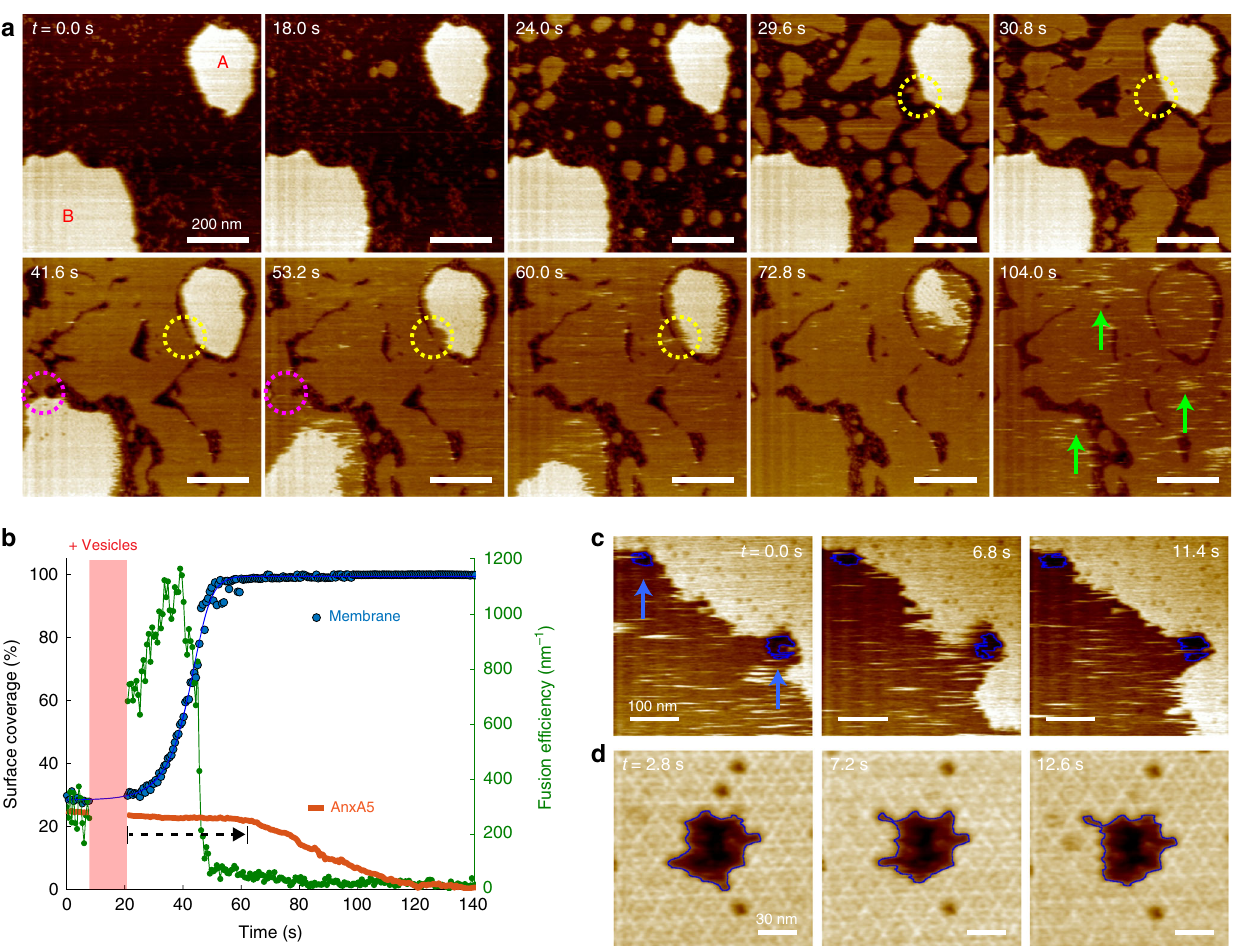
Fig. 7 HS-AFM of A5-assisted membrane healing processes. a HS-AFM image frames (Supplementary Movie 5) showing the formation of membrane, following the addition of small unilamellar vesicles into fl uid cell, in the presence of preformed membrane patches covered with A5 2D-lattices. The colored circles indicate membrane fusion locations between A5-protected membranes and newly formed membranes. Green arrows in frame 104.0 s indicate topographical stripes resulting from highly mobile A5 after membrane fusion. b Graph of the time-lapse evolution of the integrity of A5 patches A and B, total membrane surface coverage, and membrane fusion ef fi ciency, estimated by the ratio of circumference and membrane area on newly formed membrane. A5-protected membranes remain robust beyond the time of fi rst successful fusion events. c A5 dynamics (blue arrows) (Supplementary Movie 6) and d A5 2D-lattice dynamics (blue lines) (Supplementary Movie 7) near membrane defects following the addition of supplemental A5 to the HS-AFM fl uid the scanning area, and the fusion ef fi ciency of new membranes, as a function of time: The A5 membrane patches A and B remain basically unaltered (Fig. 7b, black dashed arrow), while new protein-free membrane patches are ef fi ciently formed (Fig. 7b, green) leading to almost total surface coverage.